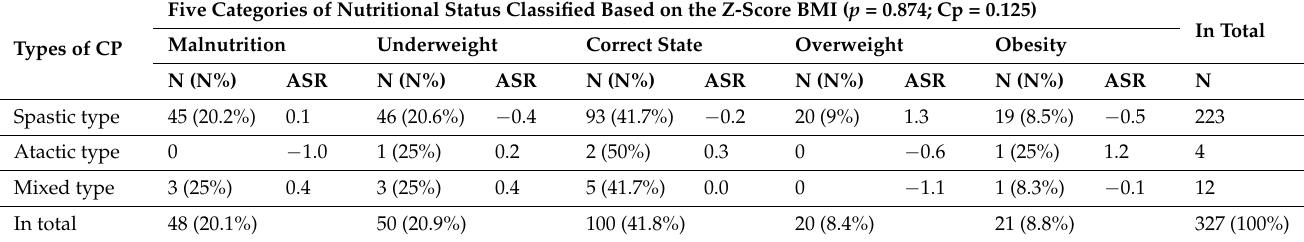
Table 11. Relationship between five categories of nutritional status classified based on the BMI z-score and types of CP.